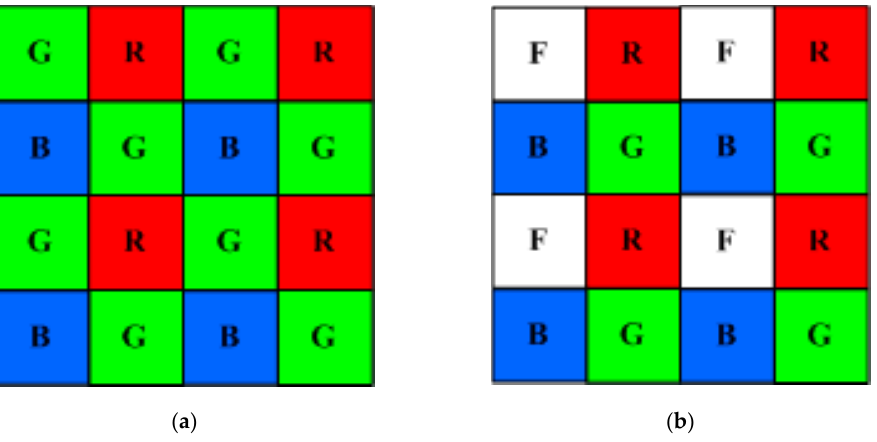
Figure 1. Schematic diagrams showing ( a ) Bayer color filter array and ( b ) modified Bayer color filter